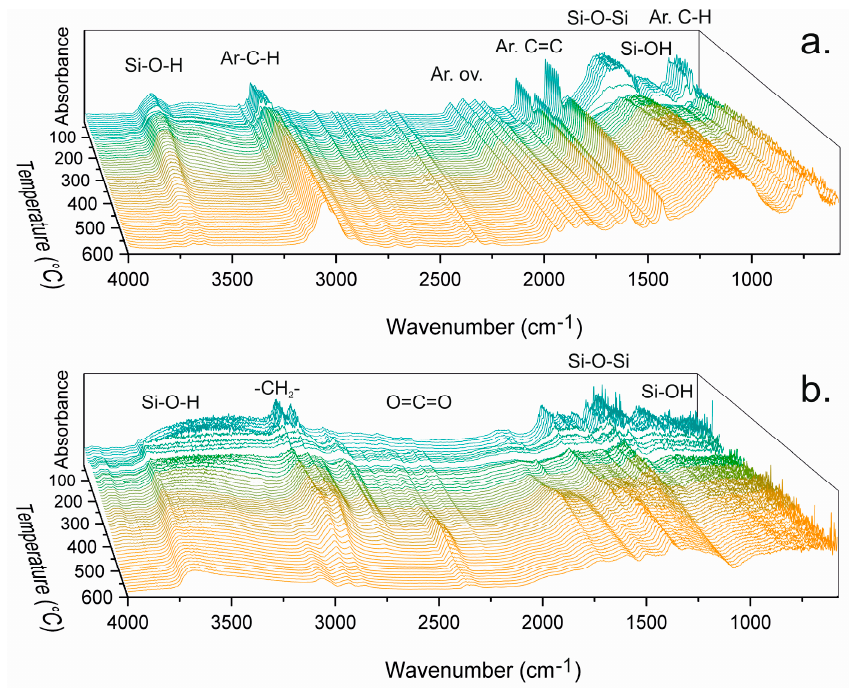
Figure 3. Temperature-dependent diffuse reflectance FTIR spectroscopy (DRIFTS) data of several organosilica networks. Condensed material derived from ( a ) PhTMS; ( b )